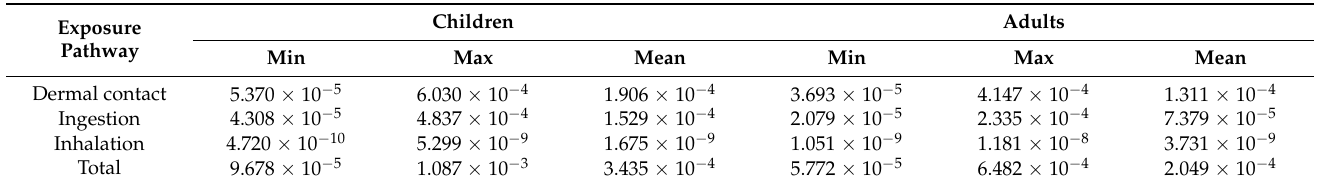
Table 7. The ranges of lifetime carcinogenic risk assessment (ILCR) in children and adults with three exposure